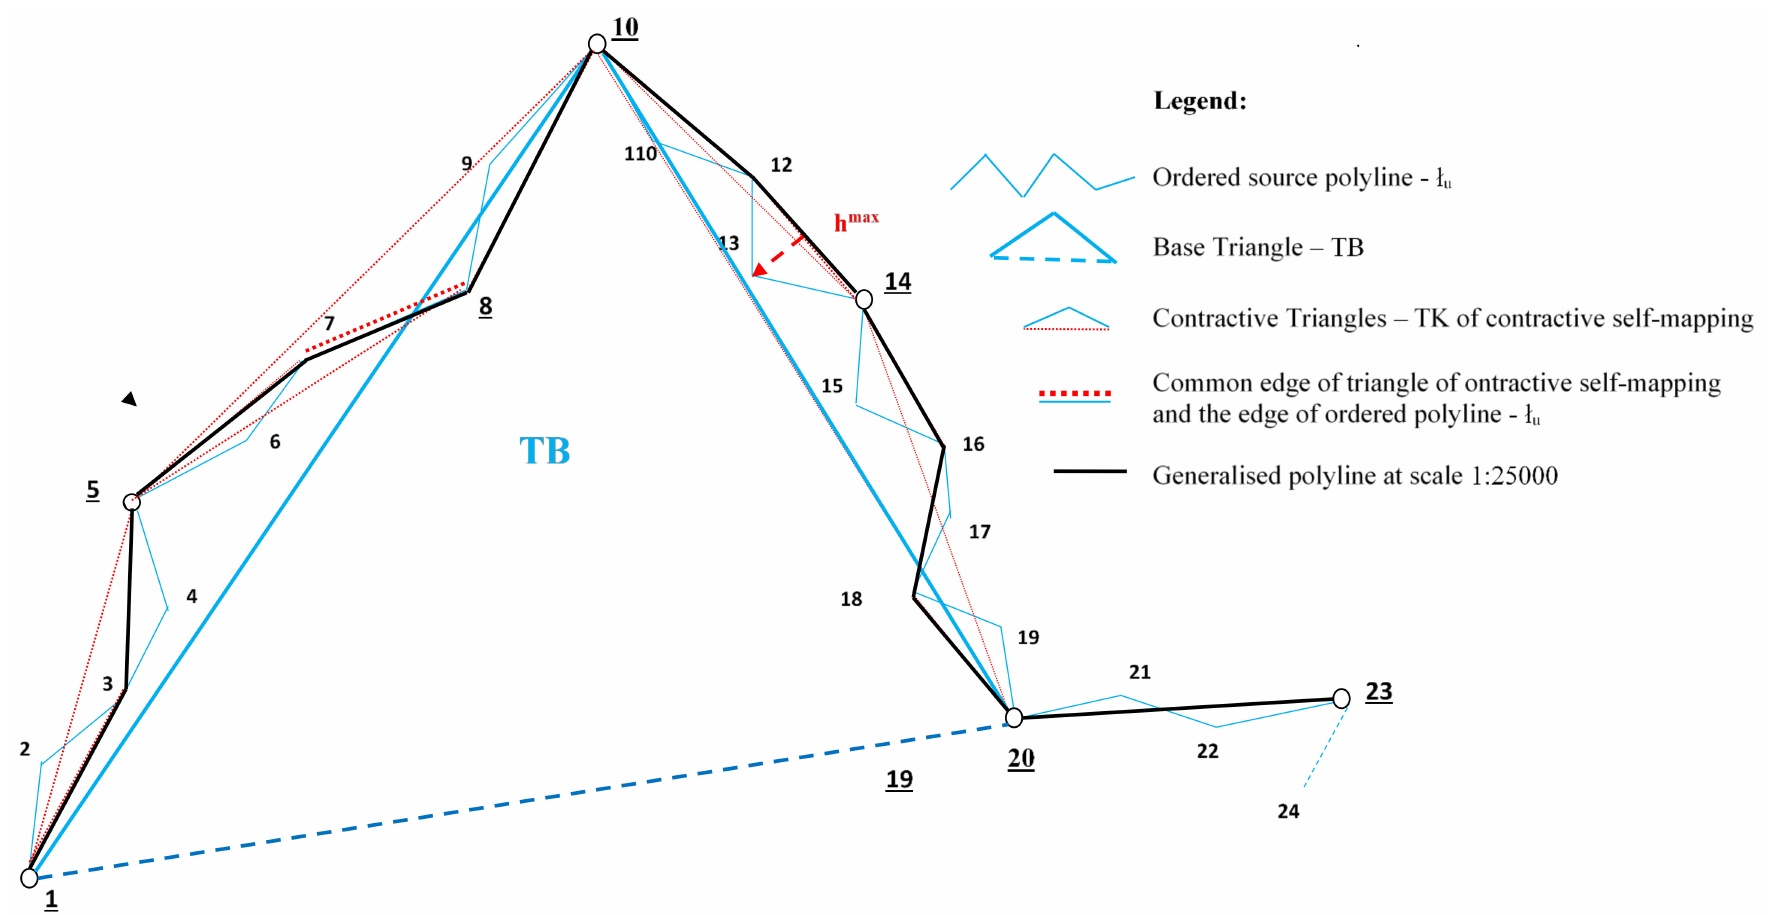
Figure A4. Generalisation of ordered polyline— l u to scale 1:25,000 (from the source scale 1:10,000) with contractive mapping of the triangles TK created in binary tree system and the verification of dimensions of triangles in accordance with Couchy condition and minimum dimensions of Salishchev for: bases-p AS = 17.5 m, p min = 18.0 m ± 4.0 m → p AS < p min , heights-h AS = 8.5 m, h max = 8.5 m ± 2.0 m → h AS > h max